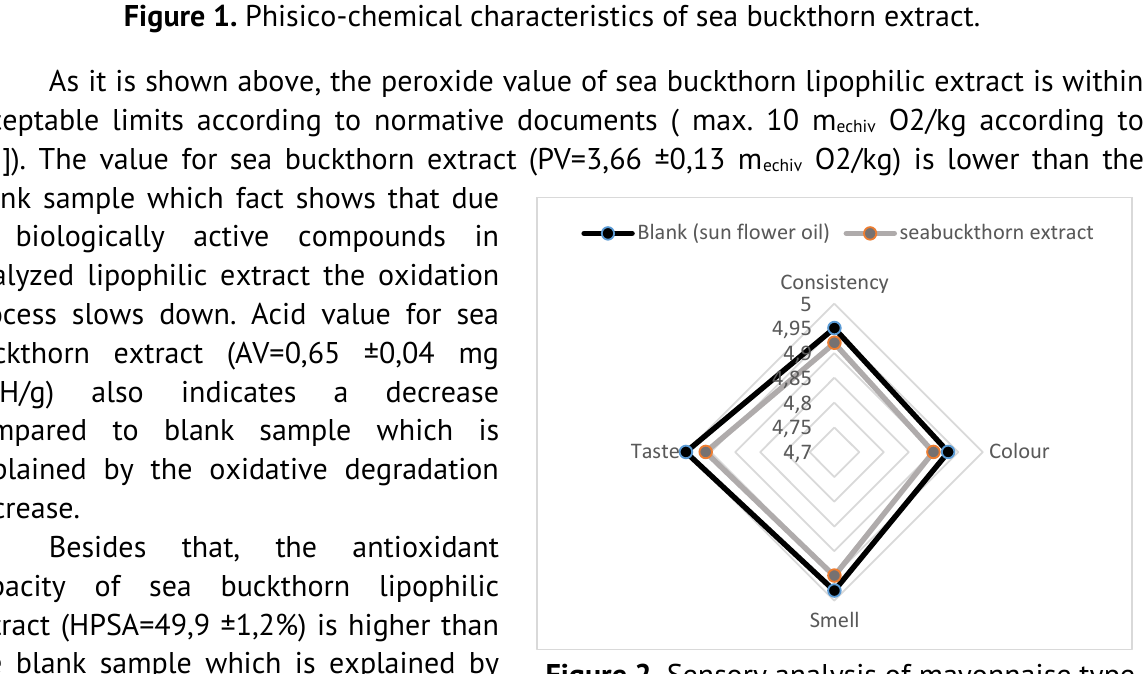
Figure 1. Phisico-chemical characteristics of sea buckthorn extract.